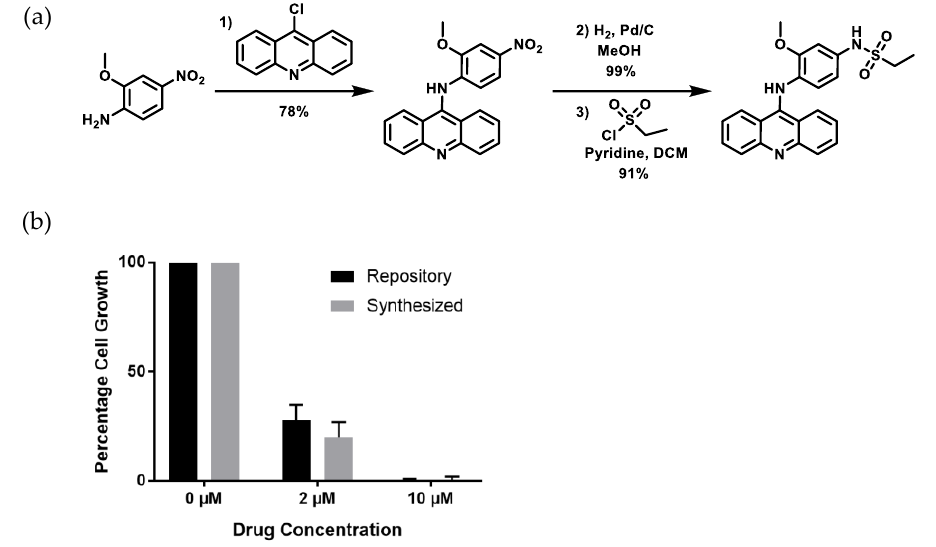
Figure 3. Synthesis and confirmation of NSC243928 activity. ( a ) Synthesis of NSC243928. Conditions: (1) 9-Chloroacridine, N-methyl-2-pyrrolidone (NMP), HCl, room temperature for 2 h. (2) H 2 , Pd/C, MeOH, room temperature for 2 h. (3) Ethane sulfonyl chloride, Pyridine, DCM, 0 ◦ C to room temperature, overnight. ( b ) Cell death activity of repository (NCI) and synthesized (USC) compound in HeLa